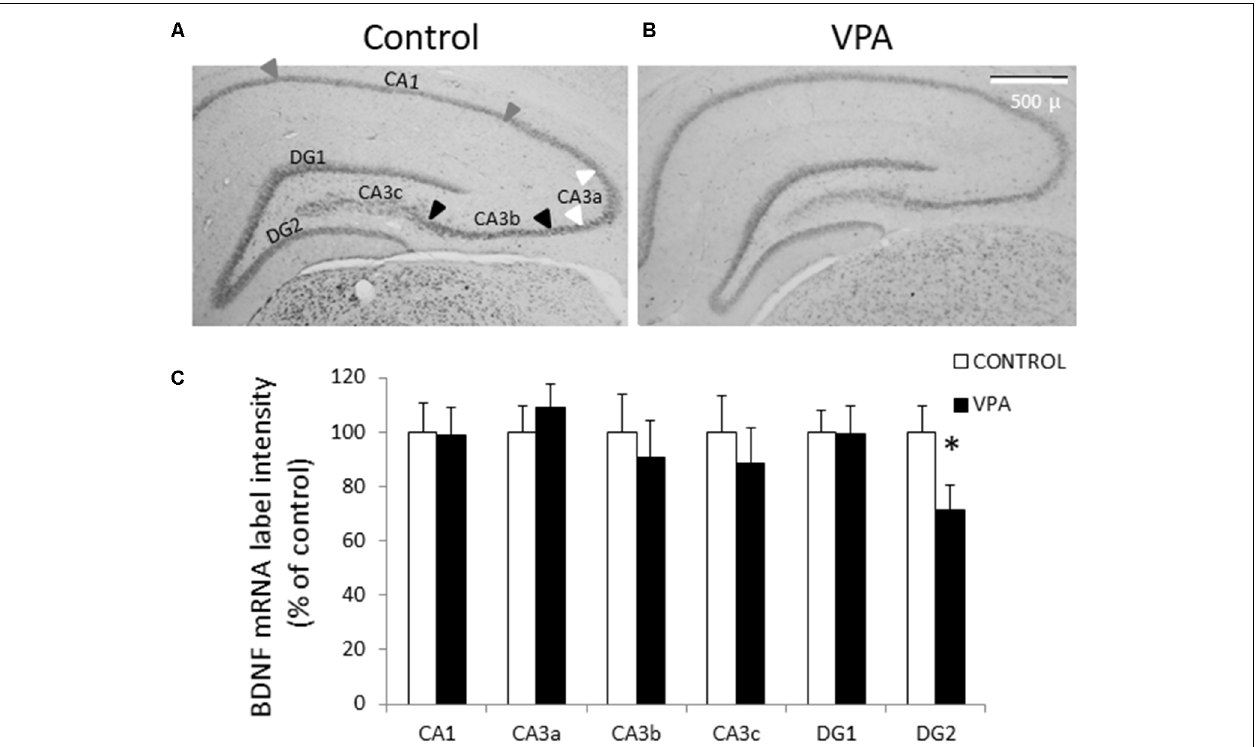
FIGURE 2 | Prenatal VPA treatment decreases brain derived neurotrophic factor (BDNF) mRNA levels in the inferior blade of the dentate gyrus (DG) hippocampal region. Representative microphotographs showing in situ hybridization (ISH) labeling for pan- bdnf transcripts in postnatal day 30 (PN30) hippocampus from controls (A) and prenatally VPA-treated rats (B) . Immunolabeling intensity of digital microphotographs from control and experimental animals was analyzed in the different layers of hippocampal subfields and expressed as percentage of controls (C) . The data represent the mean ± SEM of BDNF mRNA label intensity. Controls are represented by white bars and VPA-treated animals are represented by black bars. ∗ p < 0.05, U -test. n = 8 for control and VPA-treated rats. DG1: superior blade of DG, DG2: inferior blade of DG, CA1: Cornu ammonis region 1, CA3a-c: Cornu ammonis region 3 from the semicircular lateral extreme (CA3a) to the polymorphic zone entering in the hilus (CA3c), with the horizontal pyramidal zone (CA3b) between these two regions. Arrowheads in (A) indicates the CA1 (gray), CA3a (white) and CA3b (black) regions considered for the analysis. The scale bar represents 500 µ